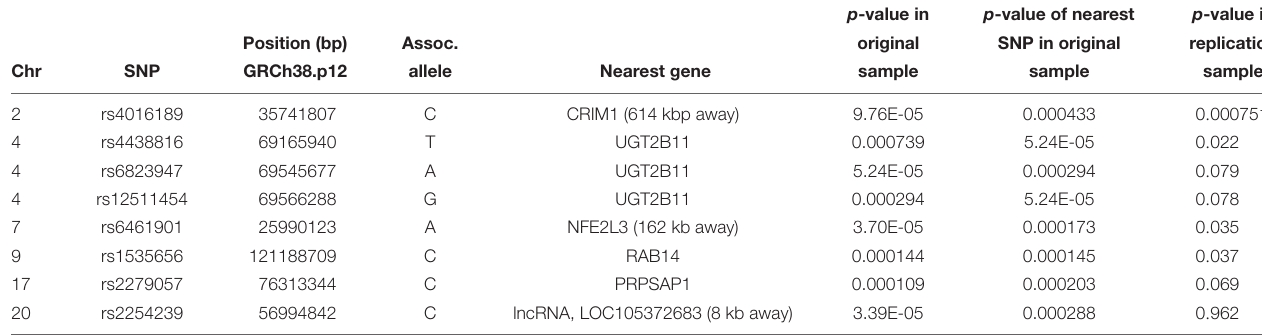
TABLE 3 | Allele frequencies of the associated alleles for SNPs that were significant in the replication study (p < 0.05). Assoc Allele freq. in Allele freq. in Allele freq Allele freq. Allele freq. Gene Tiwi Cohort 1 Tiwi Cohort 2 in MEX in YRI CRIM1 (614 kbp away)